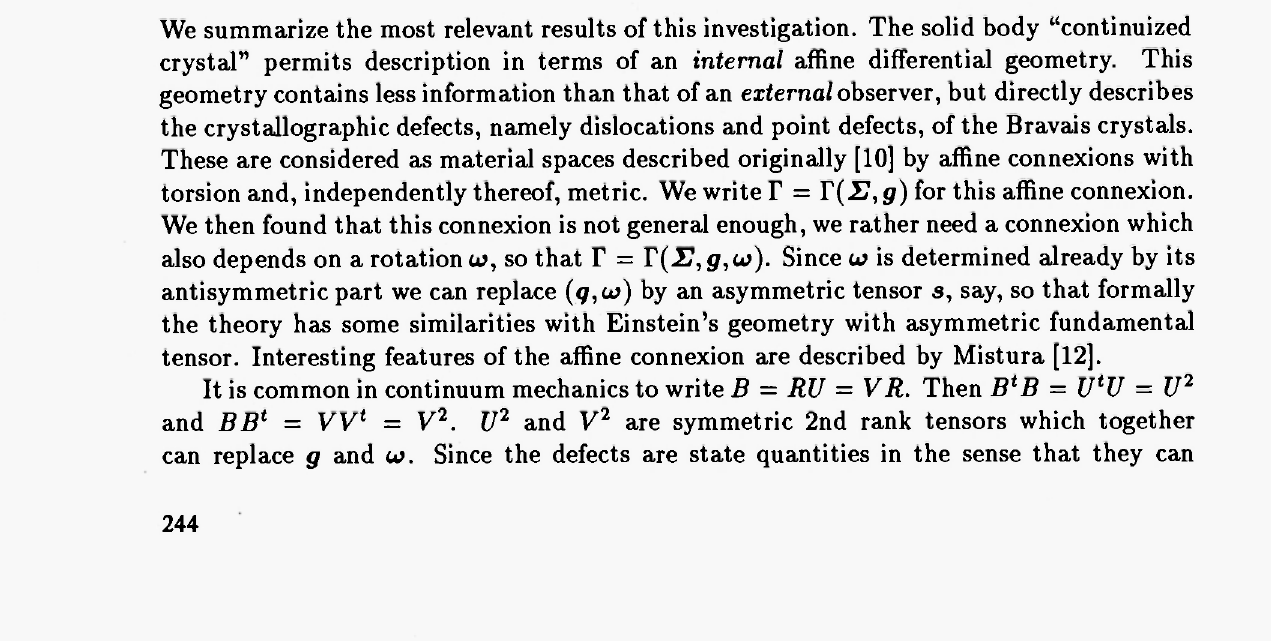
Fig.2. When repeated with the same step program, a closed circuit in a crystal defected by vacancies (a) might lead to a closure failure in an ideal crystal